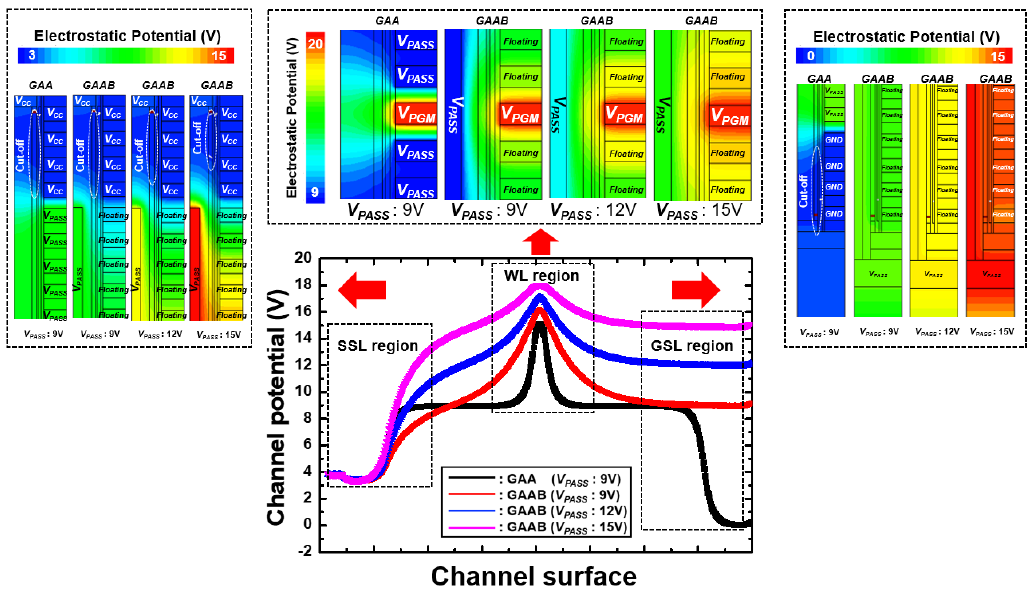
Figure 3. Inhibited channel potential in GAA and GAAB NAND structure at t Boosting and electrostatic potential at each region.